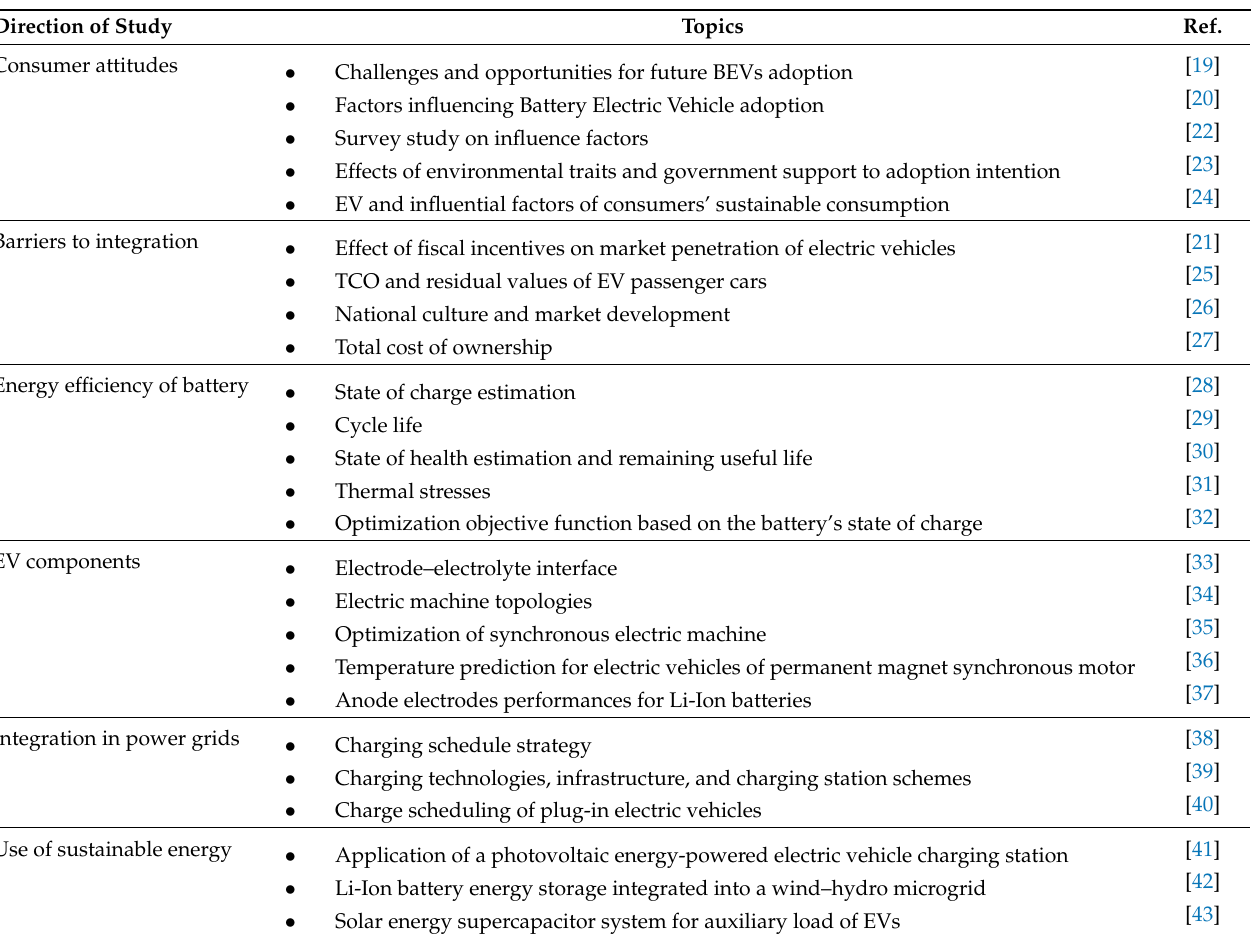
Table 1. Literature studies on EV adoption issues. Topics